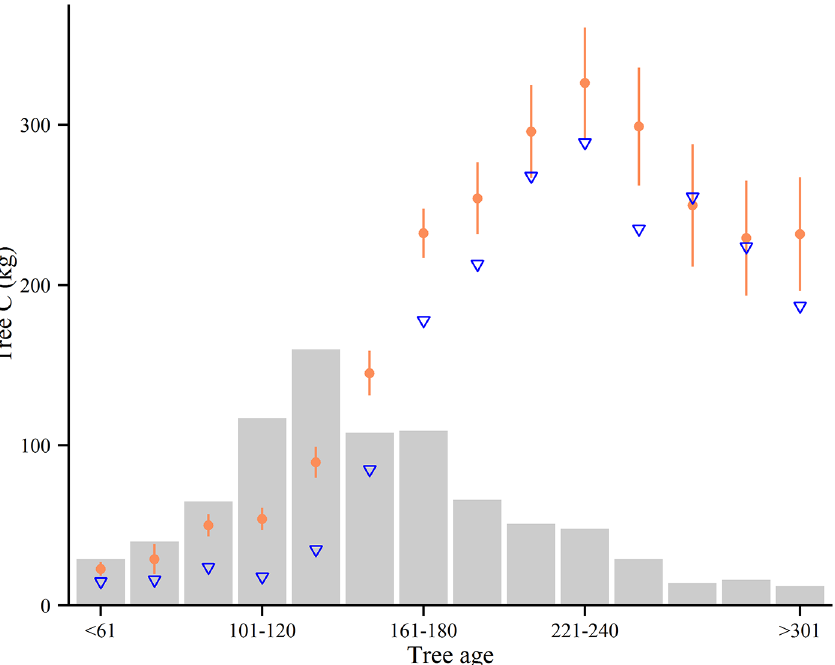
Fig 4. Individual tree age and C stock. The relationship between mean tree C stocks (filled circles) and median (triangles) for age groups (n = 805). Error bars indicate 95% confidence interval around mean. Bars indicate number of stems in each age